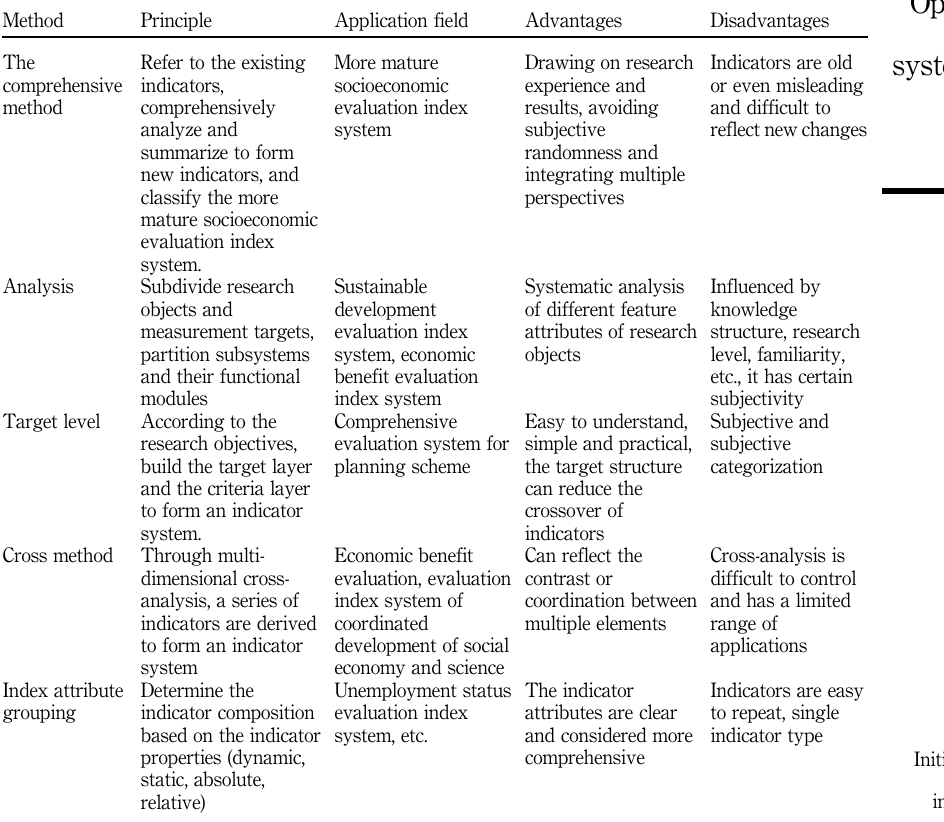
Table II. Initial